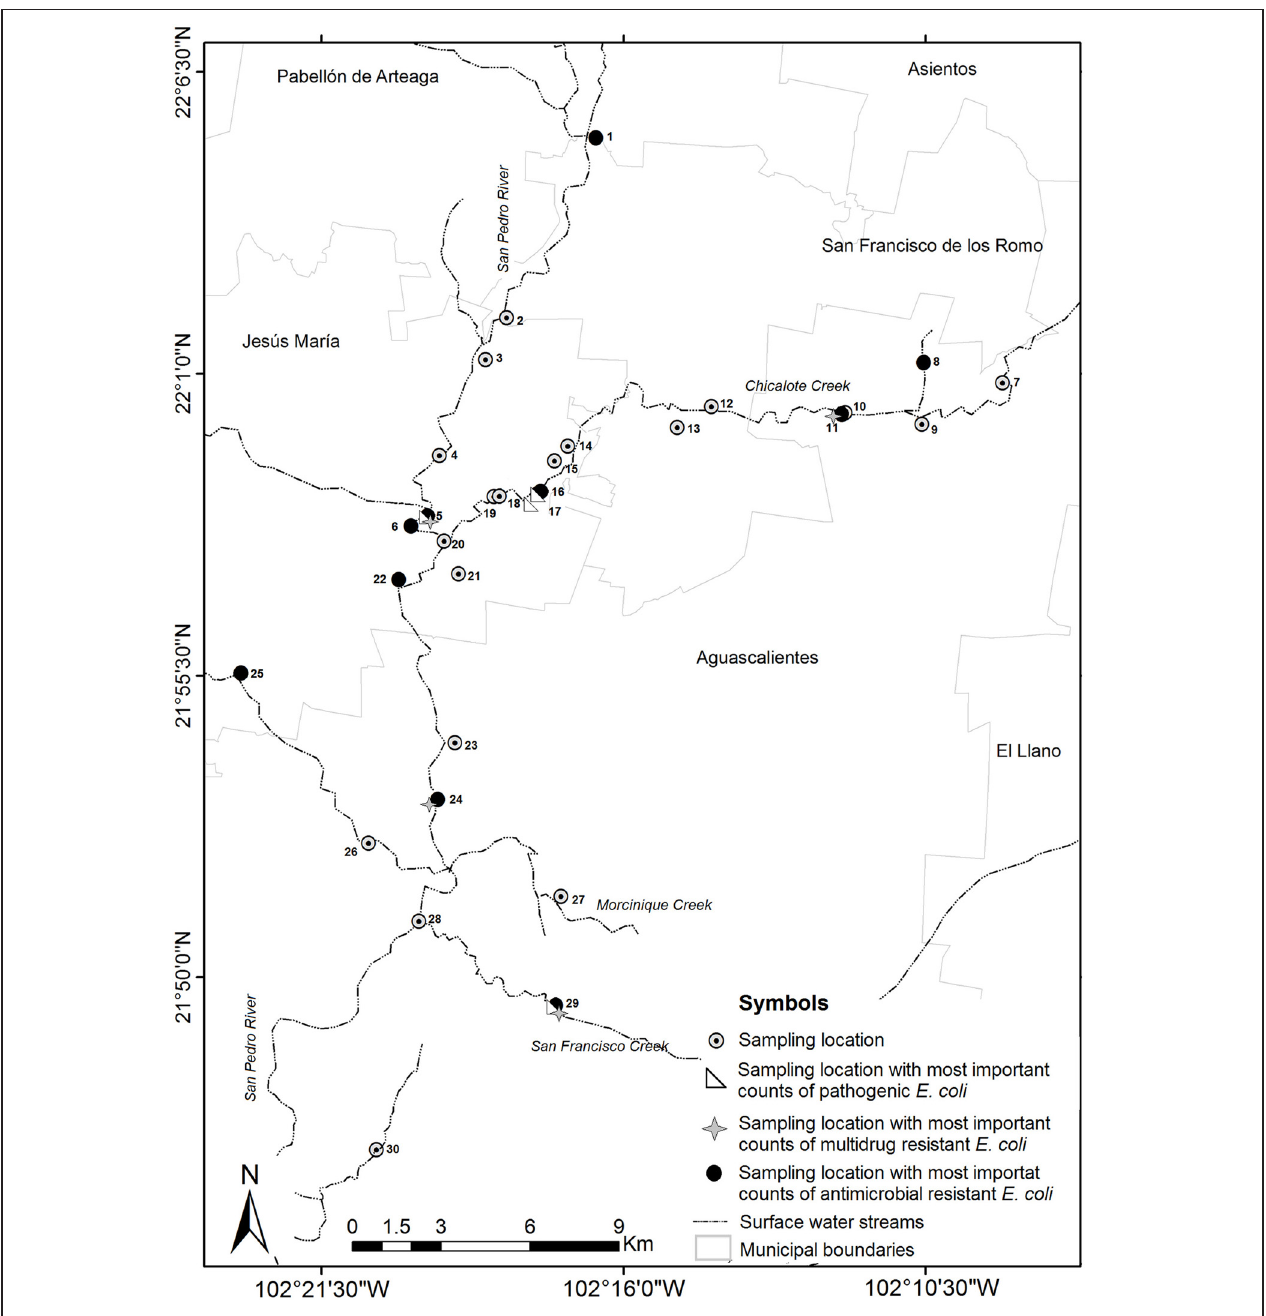
FIGURE A1 | Diagram showing the highest levels of pollution, highest counts of the pathotype, and antimicrobial resistant bacteria of the sample locations studied.